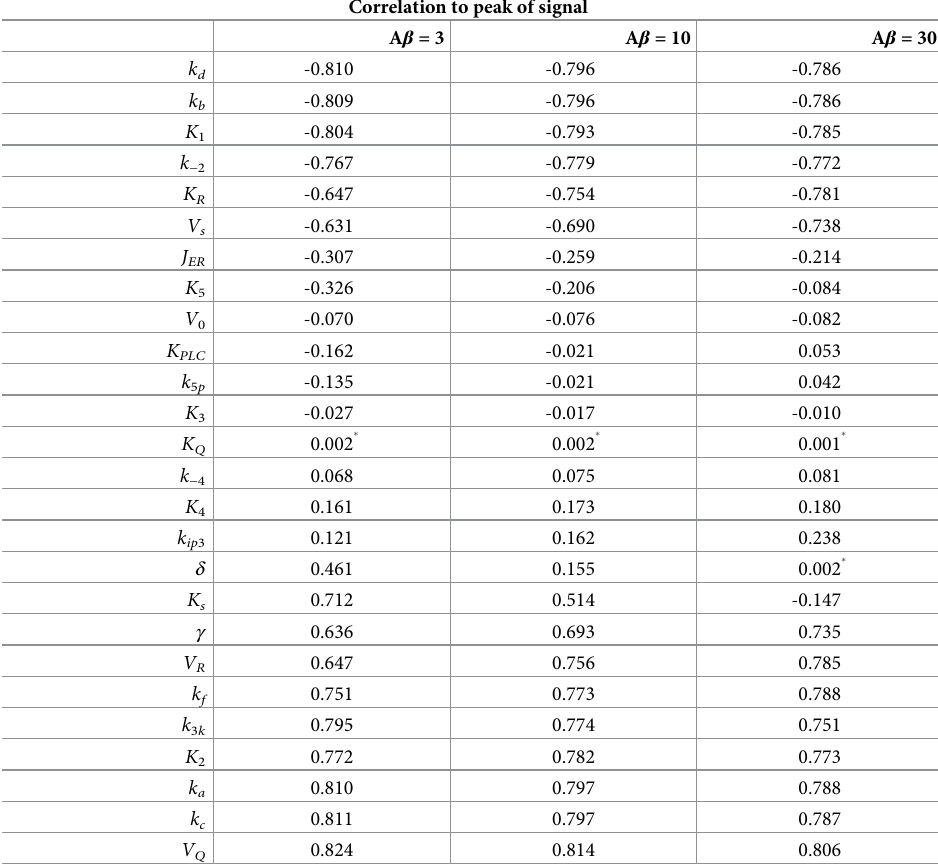
Table 3. Partial rank correlation coefficient sensitivity analysis between model parameters ( n = 100, 000) and the maximum Ca 2+ concentrations for each of the three levels of A β . Results are with 10% variation in parameters val- ues. � indicates the correlation coefficient is not significant at the p = 0.05